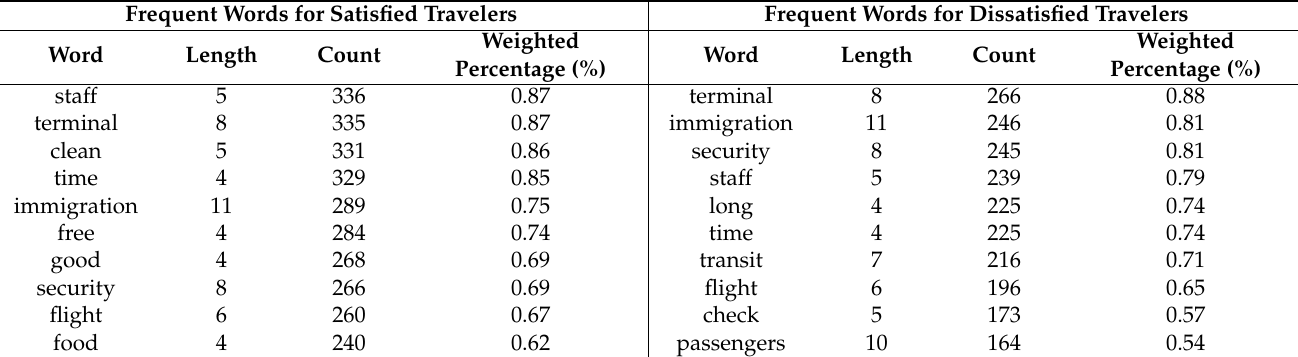
Table 4. Frequently Occurring Words for the World’s Leading